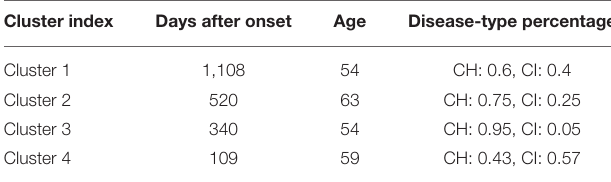
TABLE 4 | Characteristics of cluster under data time slot = 5 s, K =